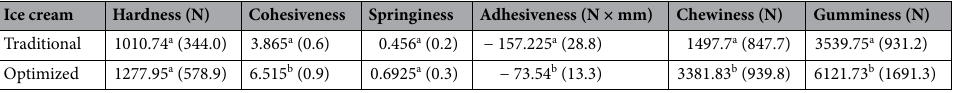
Table 4. Texture profile analysis TPA of the two ice cream formulated with milk cream (traditional) and with the optimized emulsion, respectively. The values in parenthesis are the standard deviations. abc In the same column, means without the same letter reveal significant differences ( p < 0.05) according to the LSD multiple range